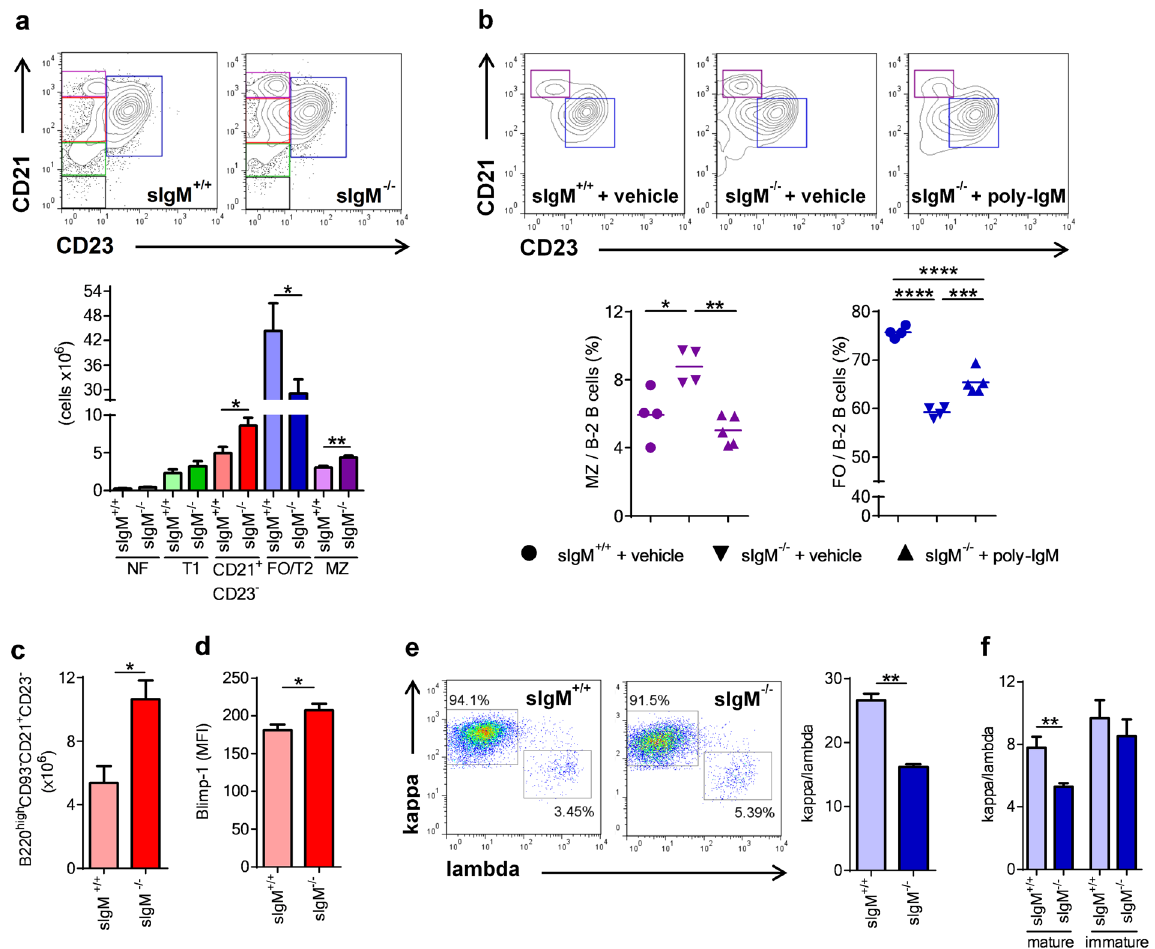
Figure 1. sIgM deficiency results in altered splenic B cell development. ( a ) Representative flow cytometry plots and bar graphs show absolute numbers of FO/T2 (blue), MZ (purple), CD21 + CD23 − B cells (red), T1 (green) and NF (grey) cells (defined in Fig. S2) of sIgM + / + (light colored bars) and sIgM − / − (dark colored bars) mice. ( b ) Representative flow cytometry plots and dot plots show the frequencies of MZ (purple) and FO/T2 (blue) B cells of sIgM + / + ( ● ) and sIgM − / − ( ▼ ) mice treated with vehicle and sIgM − / − ( ▲ ) treated with polyclonal IgM (n = 4–5 mice per group). ( c ) Absolute numbers of splenic B220 high CD93 − CD21 + CD23 − B cells and ( d ) Blimp-1 mean fluorescence intensity (MFI) in CD21 + CD23 − B cells of sIgM + / + (light red bar) and sIgM − / − (dark red bar) mice analyzed by flow cytometry. ( e , f ) Representative flow cytometry plots show the percentages of either kappa or lambda light chain positive and bars represent the mean kappa/lambda light chain ratio of ( e ) B220 + CD43 − splenic cells and ( f ) mature (B220 high CD43 − ) and immature (B220 low CD43 − ) bone marrow cells within cells that express BCR. ( a , c – f ) Data shown are from one representative experiment of at least two to three independent experiments with 5–6 mice per group. All results show mean ± SEM. * P < 0.05, ** P < 0.01, *** P < 0.001, **** P < 0.0001 (Mann-Whitney or unpaired t test or One-Way Anova test followed by Tukey’s